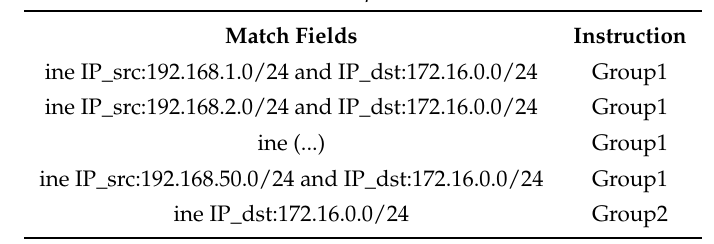
Table 1. Flow table and group table for the OpenFlow Switch using OpenFlow Fast Failover Group Table. Flow table at OpenFlow